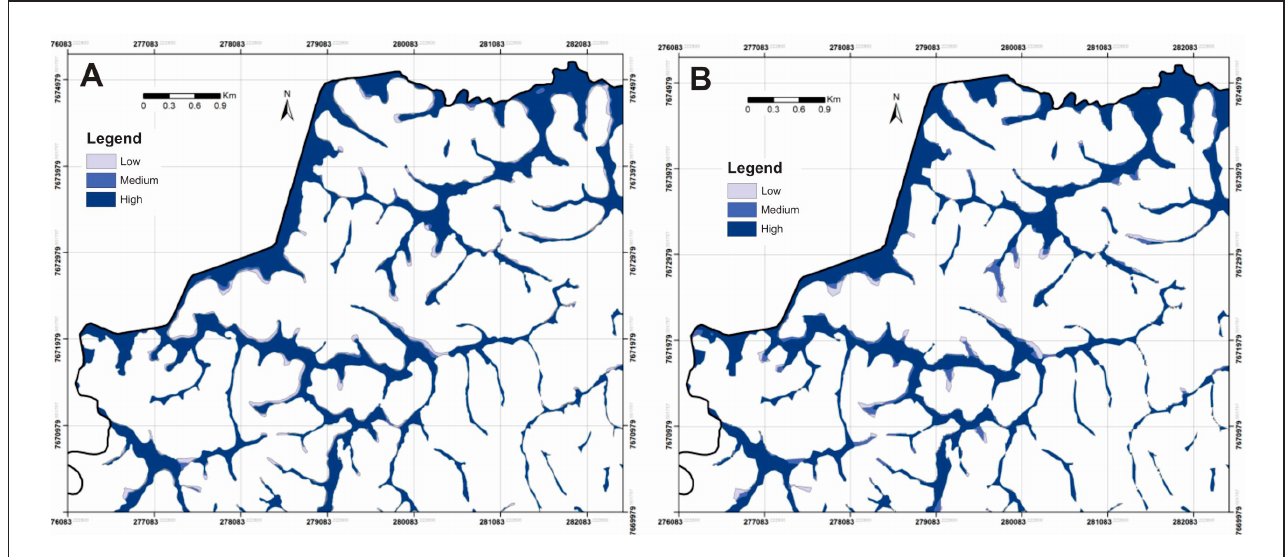
Figure 10 - Modeling detail of the southeast region of Presidente Kennedy/ES. (A) Modeling using the new methodology (Hand + morphometric information of the hydrographic basins); (B) Flood modeling using the methodology that replaces hydrographic basin information with the flood susceptibility of relief